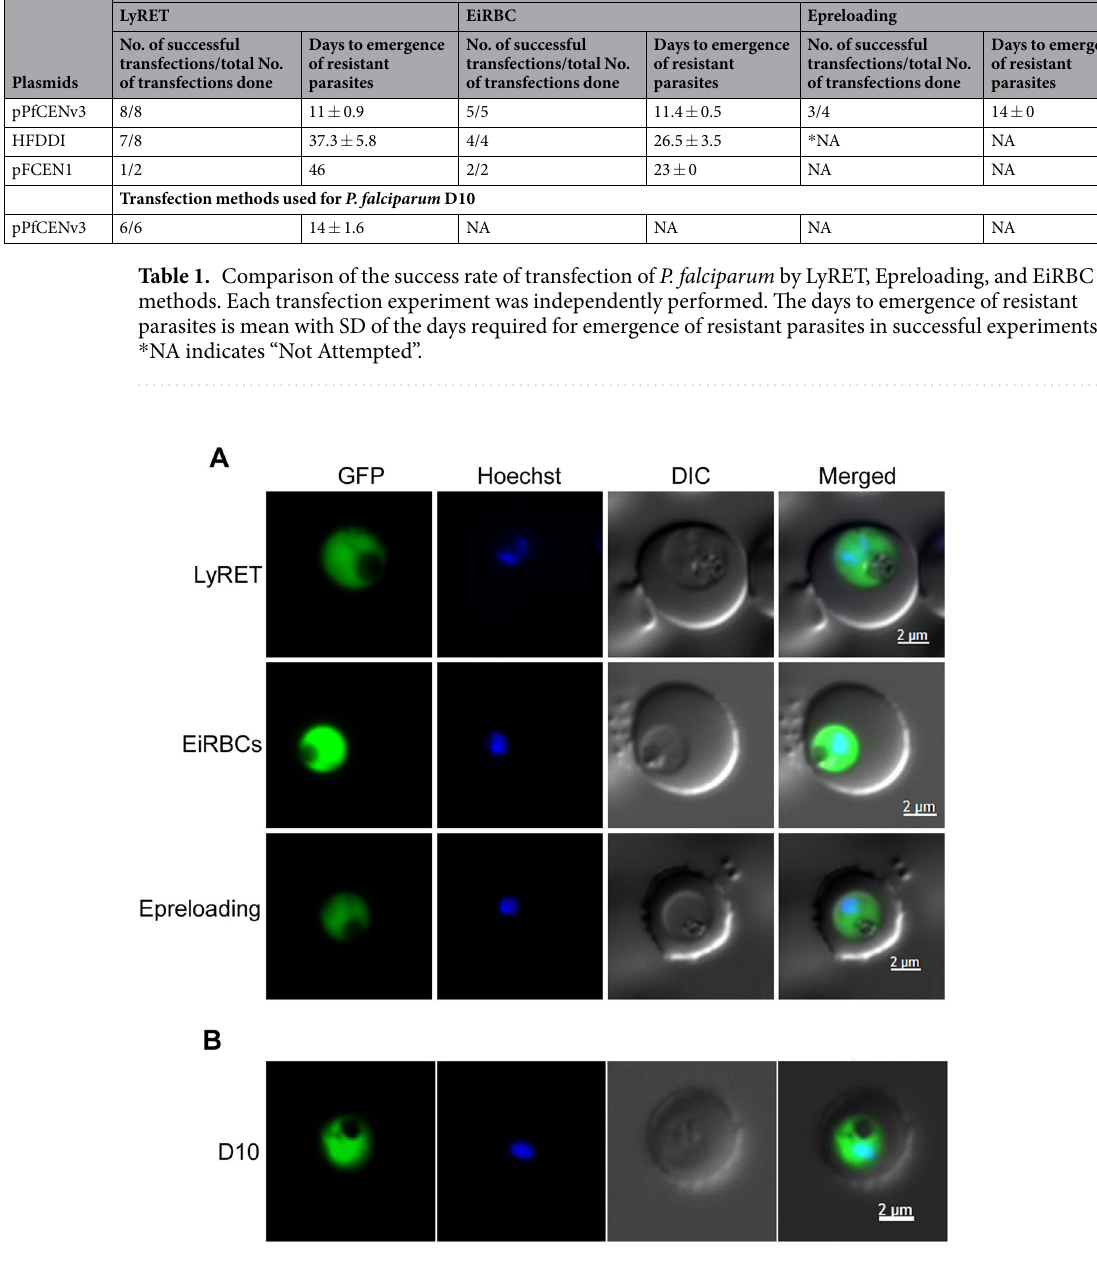
Figure 2. GFP expression in drug resistant parasites. ( A ) P. falciparum 3D7 was transfected with pPfCENv3 using LyRET, EiRBC and Epreloading methods. ( B ) P. falciparum D10 was transfected with pPfCENv3 using the LyRET method (D10). Drug resistant parasites were assessed for GFP fluorescence using live cell microscopy. Shown are the representative images for different methods. The panels in (A,B) are for GFP fluorescence in parasites (GFP), nuclear stain (Hoechst), bright field (DIC) and the overlap of all images